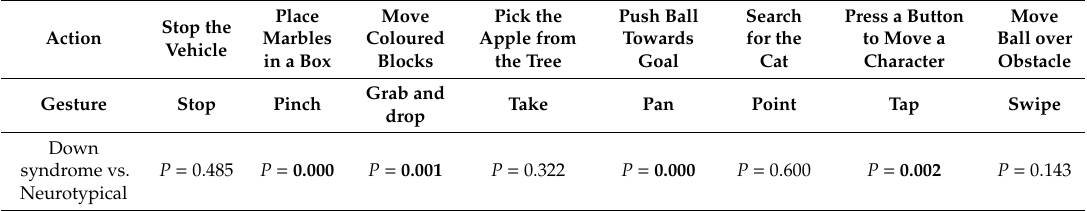
Table 4. Comparison of tasks by success